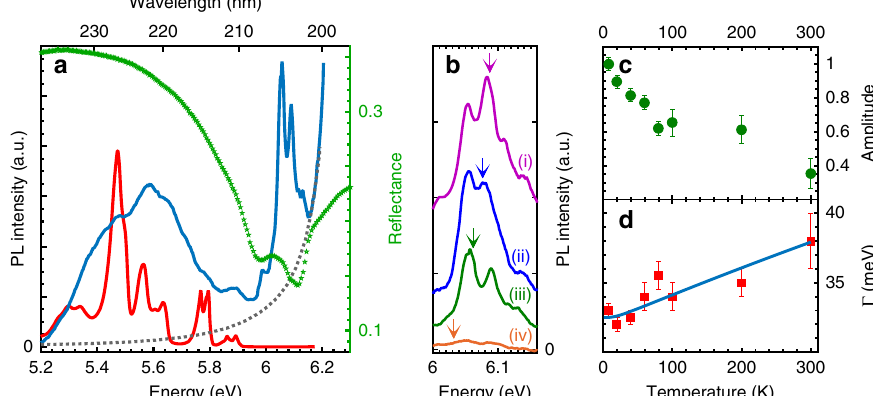
Fig. 3 Photoluminescence of epitaxial monolayer BN on graphite. a Re fl ectance spectrum (green symbols) and photoluminescence (PL) spectrum (blue solid line) of mBN on graphite at 10 K. Reference emission spectrum recorded on bare graphite without mBN (grey dotted line) showing stray light from the laser excitation. The normalised PL spectrum in bulk hBN at 10 K is plotted as a red line for comparison. b Emission of mBN (after subtraction of laser stray light) for different values of the excitation energy E ex : (i) 6.4, (ii) 6.39, (iii) 6.375, and (iv) 6.345 eV from top to bottom (the three top spectra are shifted vertically for clarity). The vertical arrows indicate the Raman-shifted energy E ex − 2 Δ , with Δ = 156 meV, corresponding to the energy of the LA(M) phonon in mBN. The vertical arrows point at: (i) 6.088, (ii) 6.078, (iii) 6.063, and (iv) 6.033 eV. c Normalised amplitude of the PL doublet lines versus temperature. d Full width at half maximum Γ of the lines in the PL doublet from 10 K to room temperature: data (symbols), fi t (solid line). Error bars indicate the standard deviations for least-squares fi tting of the PL